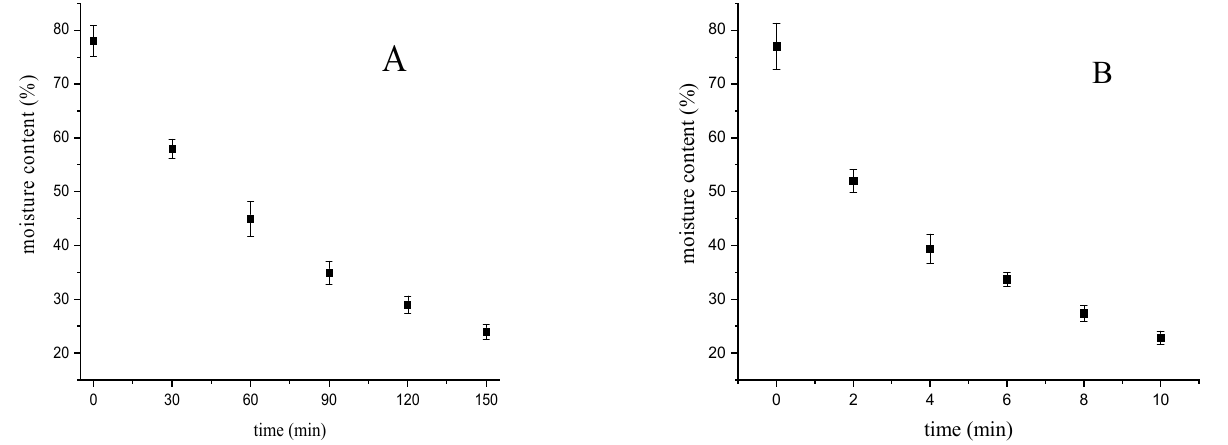
Figure 1. Drying curves of bighead carp fillets. ( A ) Hot air drying; ( B ) microwave drying. Table 1. Chemical composition and color parameters (mean ± SD) of raw, oven, and microwave drying of bighead carp H. nobilis fillets.